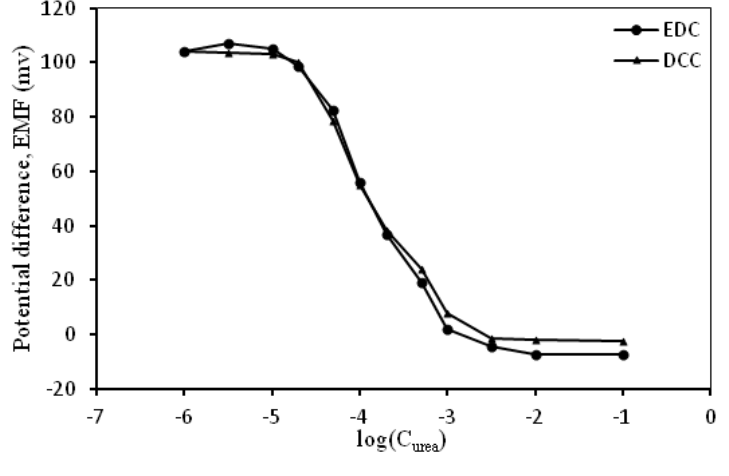
-COOH was modified by using DCC or 60